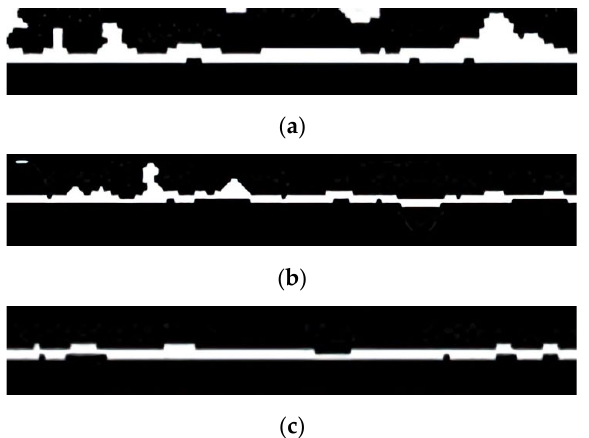
Figure 4. Images of the foulant layer by OCT (after thresholding). The white areas in the images represent the foulant layers. ( a ) Continuous operation for 4 h. ( b ) Restart after the membrane storage in the feed water (Case 2). ( c ) Restart after the membrane storage in DI water (Case 3).